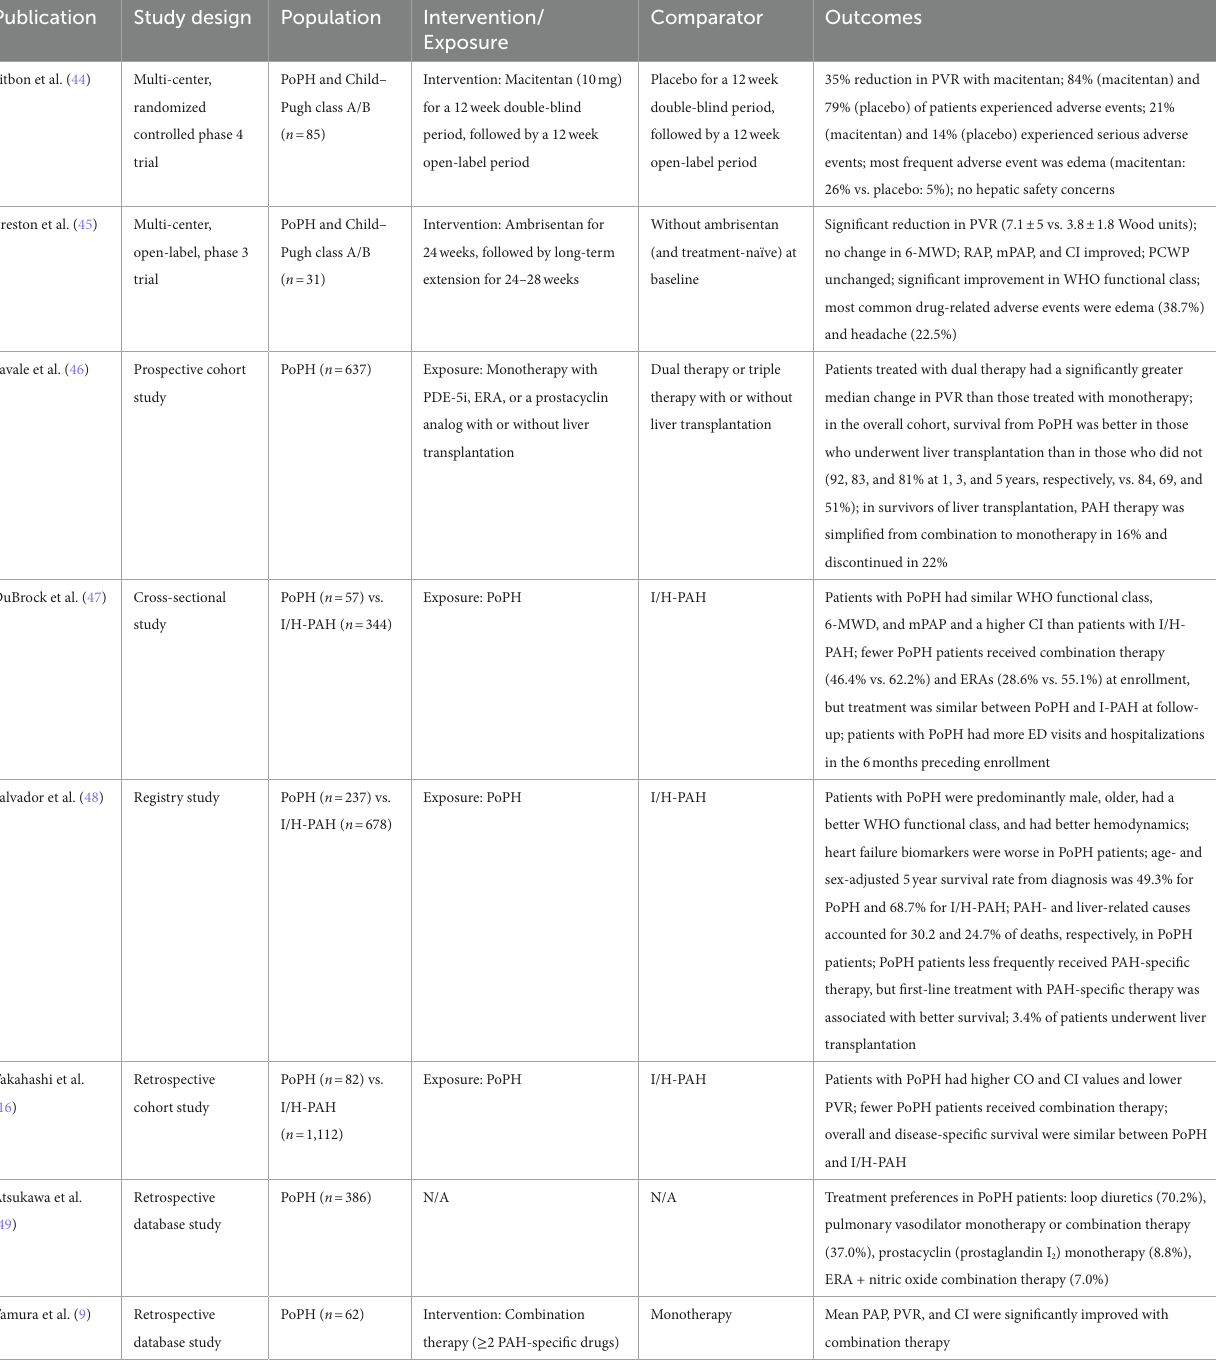
TABLE 1 Summary of recently published